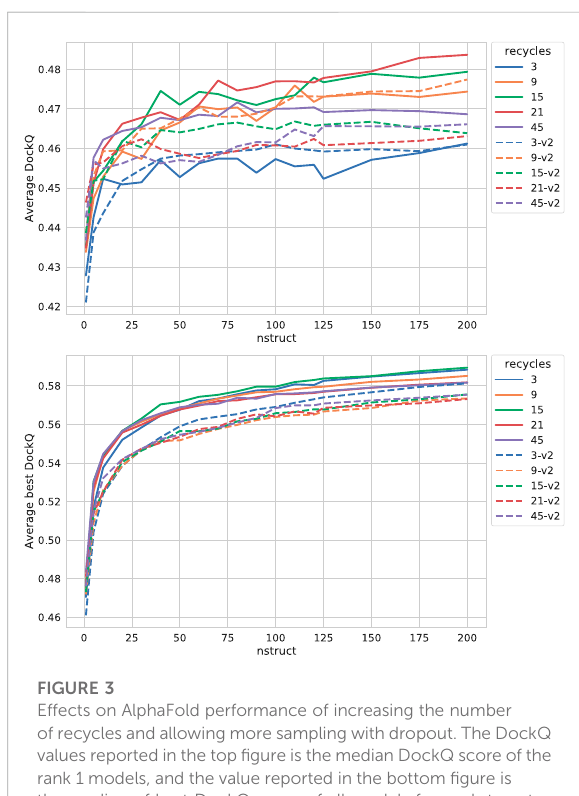
FIGURE 3 Effects on AlphaFold performance of increasing the number of recycles and allowing more sampling with dropout. The DockQ values reported in the top fi gure is the median DockQ score of the rank 1 models, and the value reported in the bottom fi gure is the median of best DockQ score of all models for each